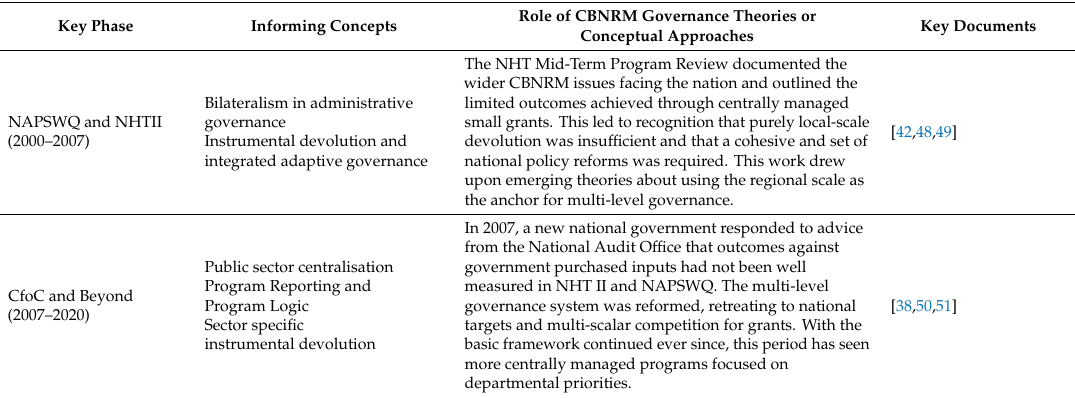
Table 1 recognises that the NAPSWQ / NHT II era was based on theories that